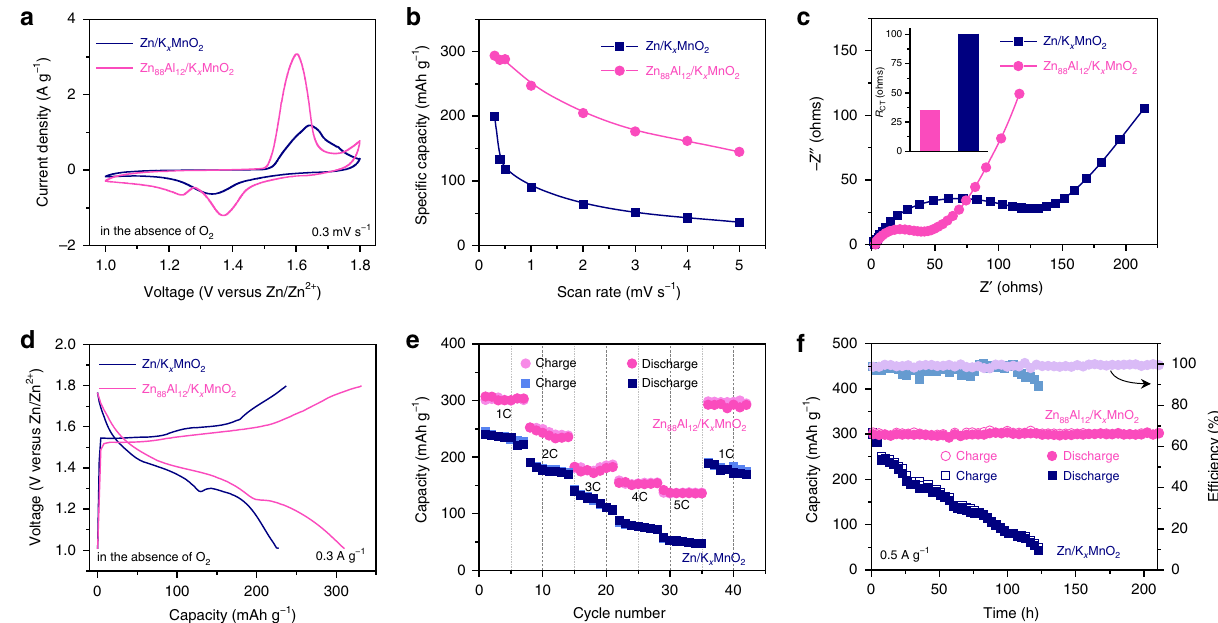
Fig. 5 Electrochemical performance of zinc-ion full batteries. a Typical CV curves for Zn 88 Al 12 /K x MnO 2 and Zn/K x MnO 2 batteries, which are constructed with the K x MnO 2 nano fi bers as the cathode and the eutectic Zn 88 Al 12 alloy ( λ = ∼ 450 nm) or the monometallic Zn as the anode, in the O 2 -absent ZnSO 4 aqueous electrolyte. Scan rate: 0.3 mV s − 1 . b Speci fi c capacities for Zn 88 Al 12 /K x MnO 2 and Zn/K x MnO 2 batteries at various scan rates. c EIS spectra of Zn 88 Al 12 /K x MnO 2 and Zn/K x MnO 2 batteries and their corresponding R CT values (inset) in the O 2 -absent ZnSO 4 aqueous electrolyte. d Typical voltage pro fi les of Zn 88 Al 12 /K x MnO 2 and Zn/K x MnO 2 batteries at the charge/discharge current density of 0.3 A g − 1 . e Comparison for rate capabilities of Zn 88 Al 12 /K x MnO 2 and Zn/K x MnO 2 batteries at various rates from 1 to 5 C. f Capacity retention and coulombic ef fi ciency of the Zn 88 Al 12 /K x MnO 2 battery in a long-term cycling test at 0.5 A g − 1 , comparing with those of the Zn/K x MnO 2